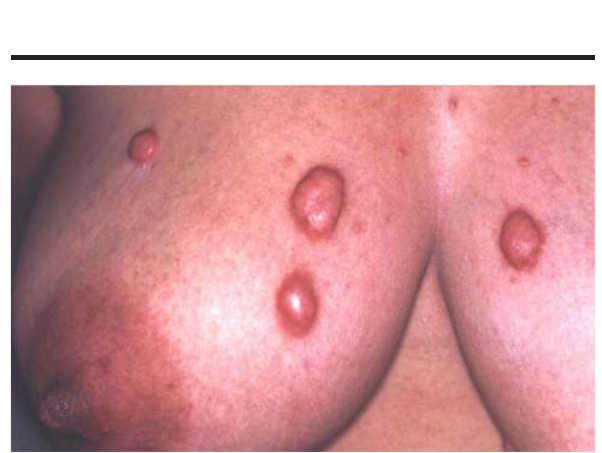
FIGURE 2 - Patient donor of the keloid, with clinically active lesions in the superior-medial quadrant of right and left